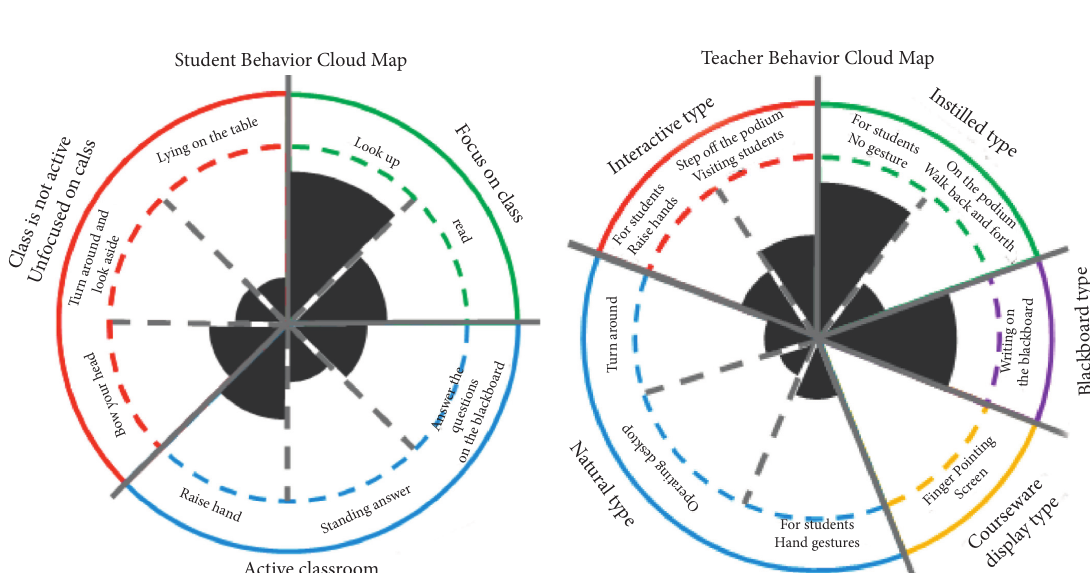
Figure 8: Visualization: classroom cloud map.